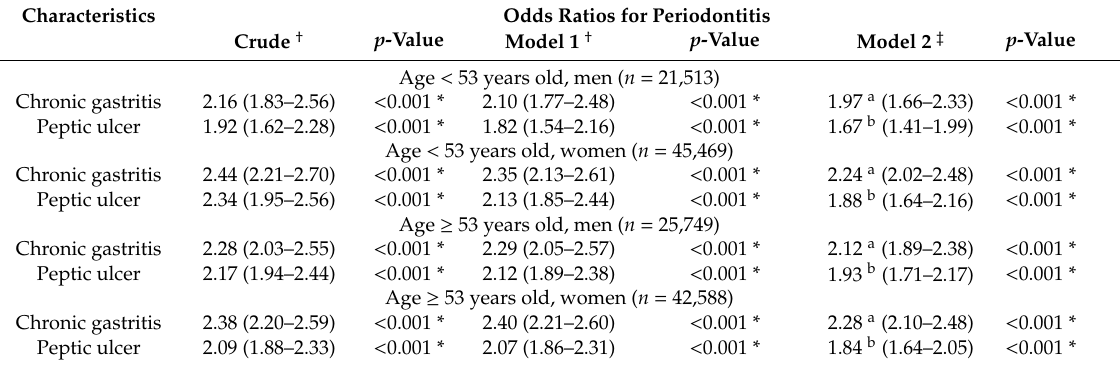
Table 3. Crude and adjusted odds ratios (95% confidence interval) of chronic gastritis and peptic ulcer for periodontitis according to age and